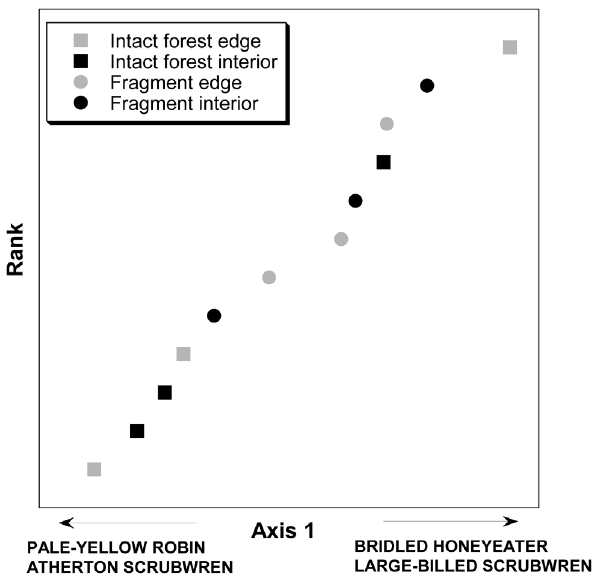
Figure 2. An ordination of bird community composition from forest edges and interiors in rainforest fragments and in intact forest study sites on the Atherton Tablelands, north-eastern Australia. Habitat fragmentation or edge effects did not influence bird community composition at these sites, as illustrated by the single significant ordination axis (explaining 60% of the variance in